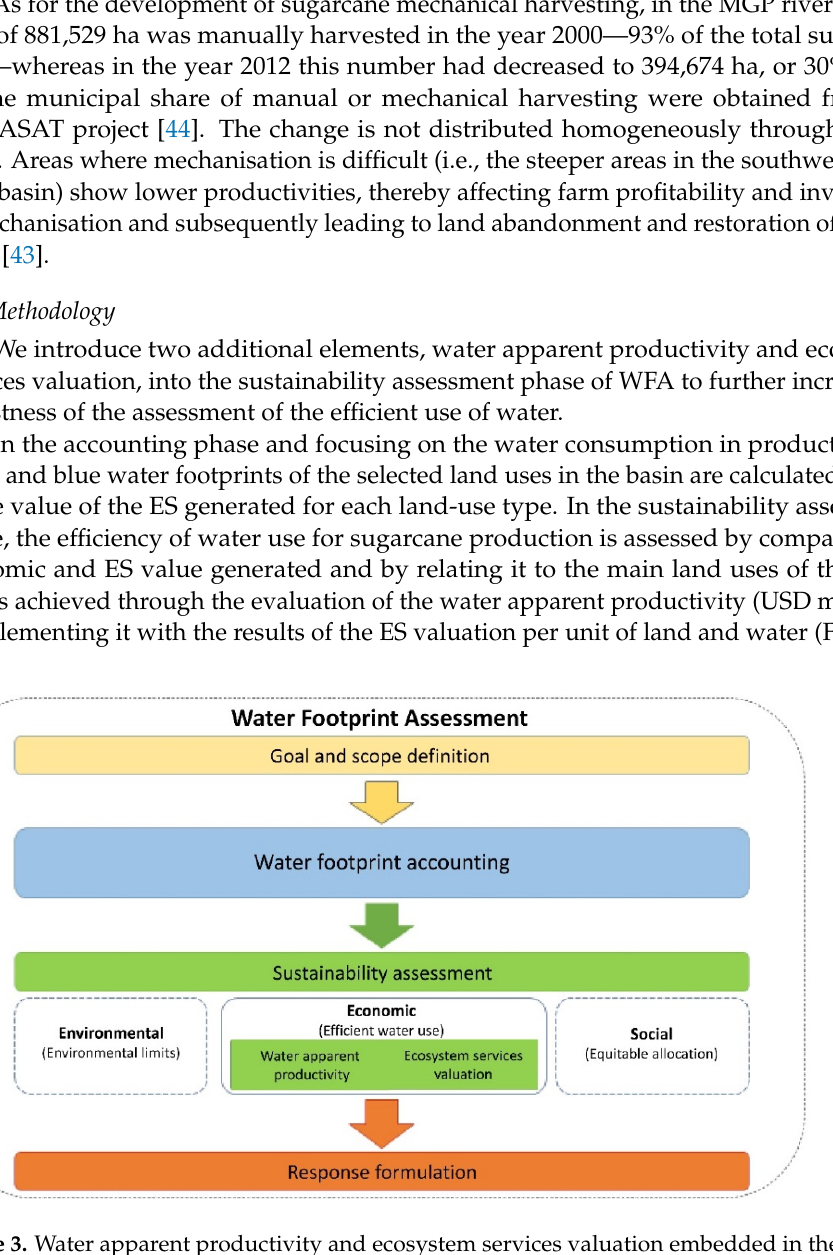
Figure 3. Water apparent productivity and ecosystem services valuation embedded in the sustain- ability assessment phase of Water Footprint